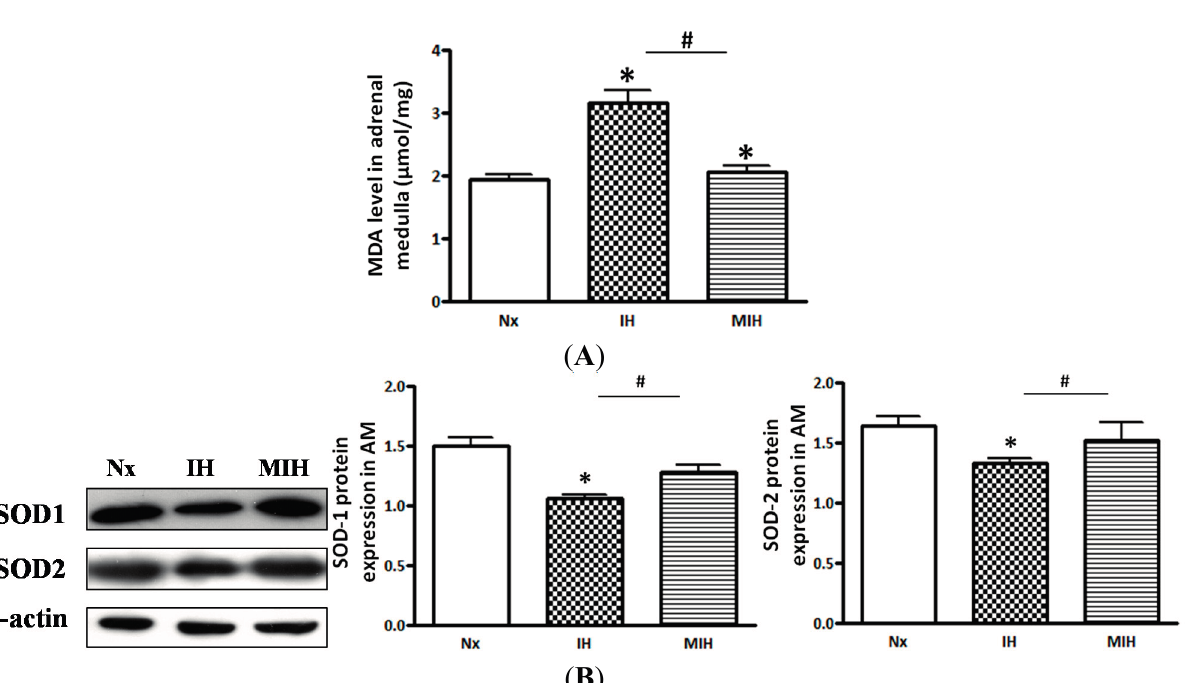
Figure 1. Levels of malondiadehyde (MDA) and the protein expression of antioxidant enzymes in adrenal medulla of hypoxic rats and controls. ( A ) The level of MDA was significantly increased in the IH group when compared with the normoxic control and hypoxic group co-treated with melatonin; and ( B ) antioxidant enzymes protein expression was significantly lower in the IH group than those of the normoxic control and MIH groups (* p < 0.05, versus normoxic control; # p < 0.05, versus IH group. n = 6 per group). Nx, normoxic control; IH, intermittent hypoxia; MIH, melatonin-treated intermittent